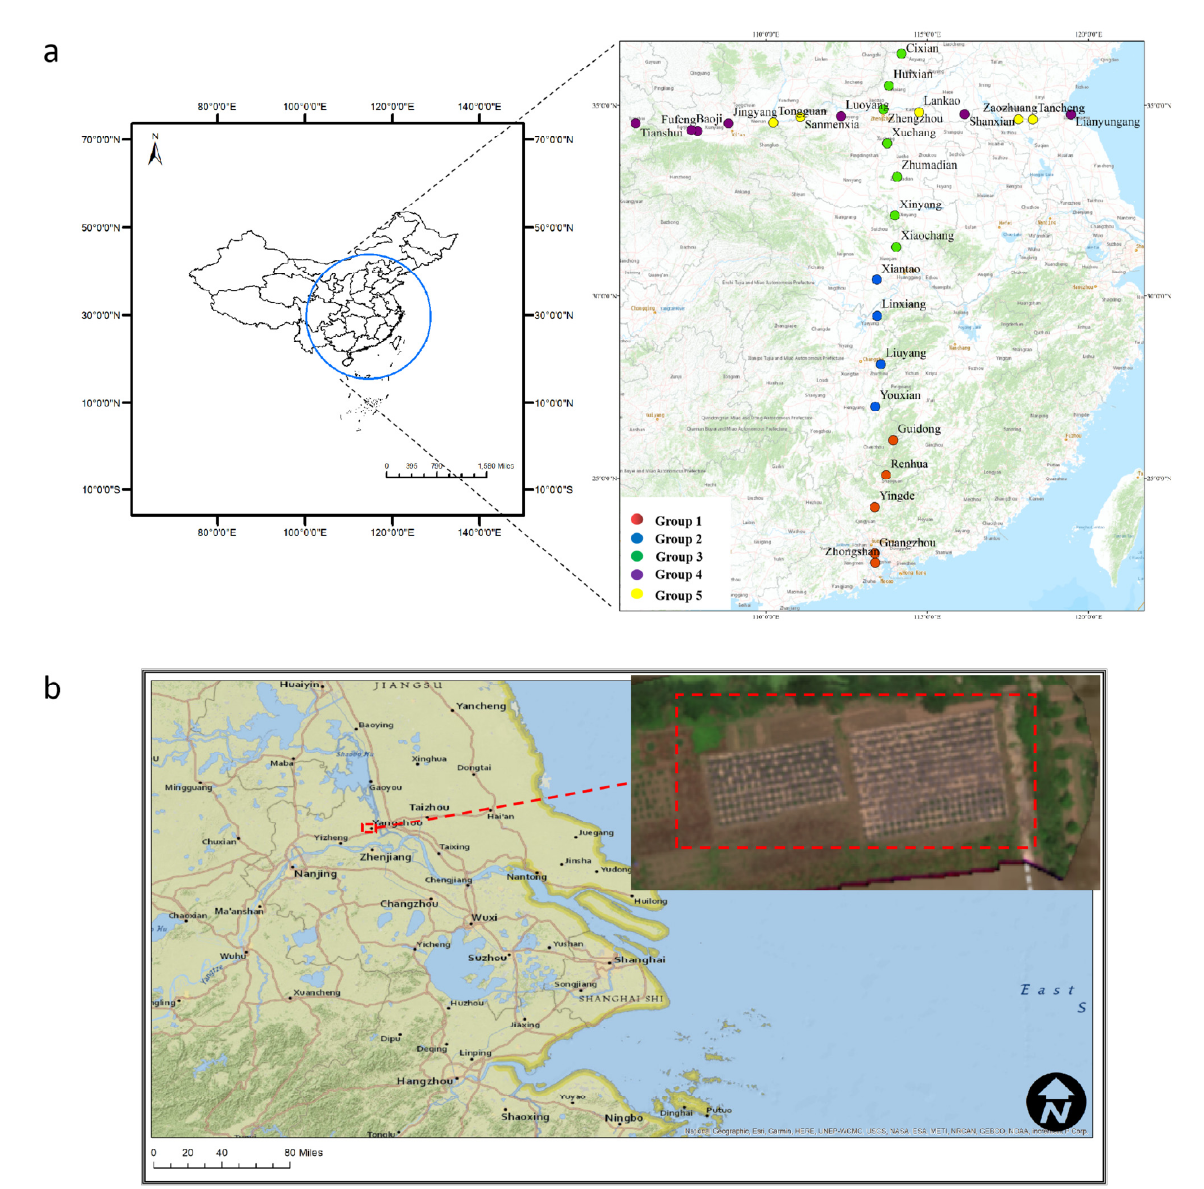
Figure 1. ( a ) Study area and sampling locations of Bermuda grass cpDNA sequences from 28 popula- tions along longitudinal and latitudinal gradients. Points represent the locations where samples were collected, and colors illustrate five distinct genotypic groups (1–5). ( b ) Location of the study area—an experimental field in the campus of Yangzhou University.